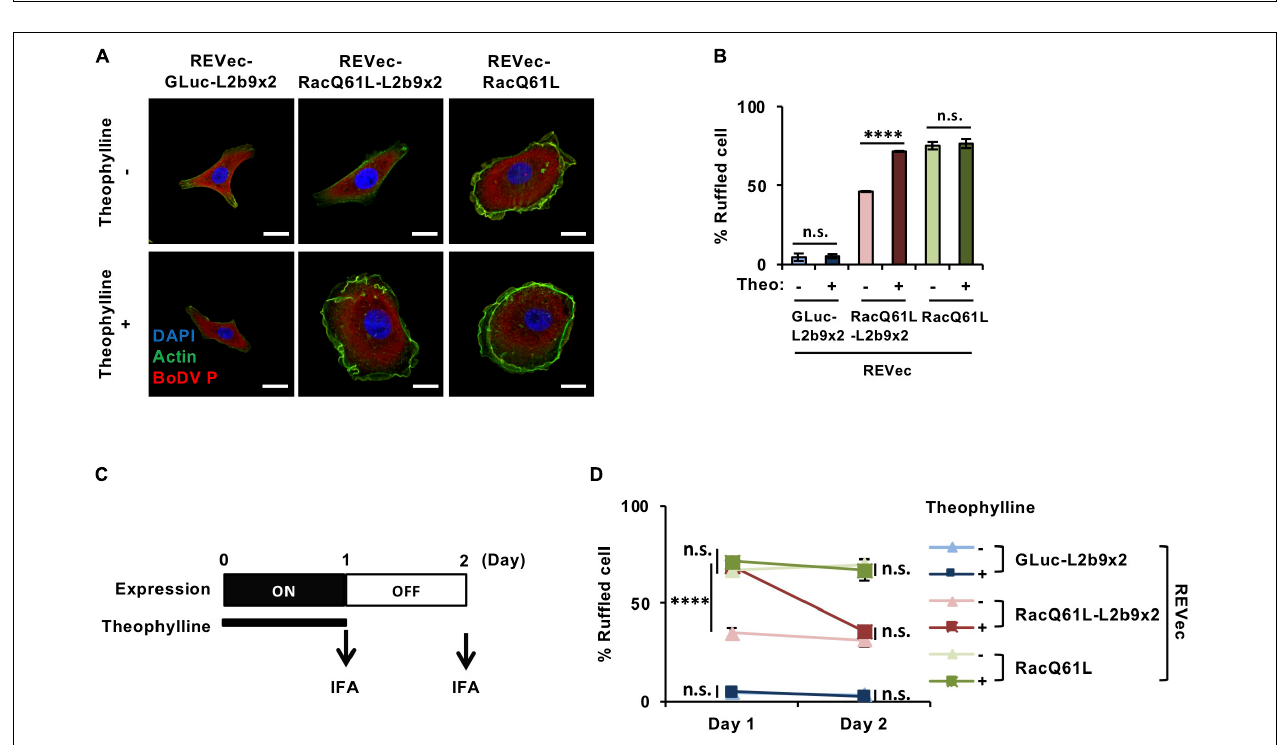
FIGURE 4 | Control of cell morphology using the REVec-L2b9 system. (A) IFA of Vero cells infected with REVec-GLuc-L2b9x2, REVec-RacQ61L-L2b9x2, and REVec-RacQ61L. Cells were incubated with or without 3 mM theophylline for 1 day. Bars, 10 µ m. (B) The percentages of ruffled cells. Cells were incubated with 3 mM theophylline for 1 day, and cell morphology was observed by IFA. (C) Time course of switching off the expression from REVec-RacQ61L-L2b9x2. Cells were incubated with 3 mM theophylline for 1 day, and then theophylline treatment was ceased on Day 1. (D) The percentages of ruffled cells on Days 1 and 2. Theophylline treatment was ceased on Day 1. Cell morphology was observed by IFA. Values are expressed as the mean ± S.E. ∗∗∗∗ P < 0.001; n.s., no significance (Student’s t -test). At least three experiments were